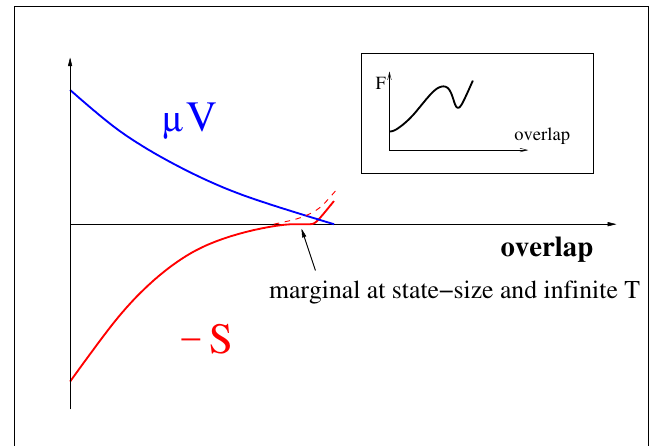
Figure 4: The Franz-Parisi potential [ 45, 46 ] : complexity (the log number of metastable states at a given overlap) and interaction energy, both plotted in terms of the overlap. At the point in which the overlap coincides with the state size, the entropy is the one of a single system, and the point is marginal. At larger over- laps, i.e within a state, the complexity becomes negative. The dashed line represents the correction coming from counting states with finite lifetime, as one must at fi- nite "quantum temperature". The sum of the attraction and entropic effects yields a first-order transition mechanism